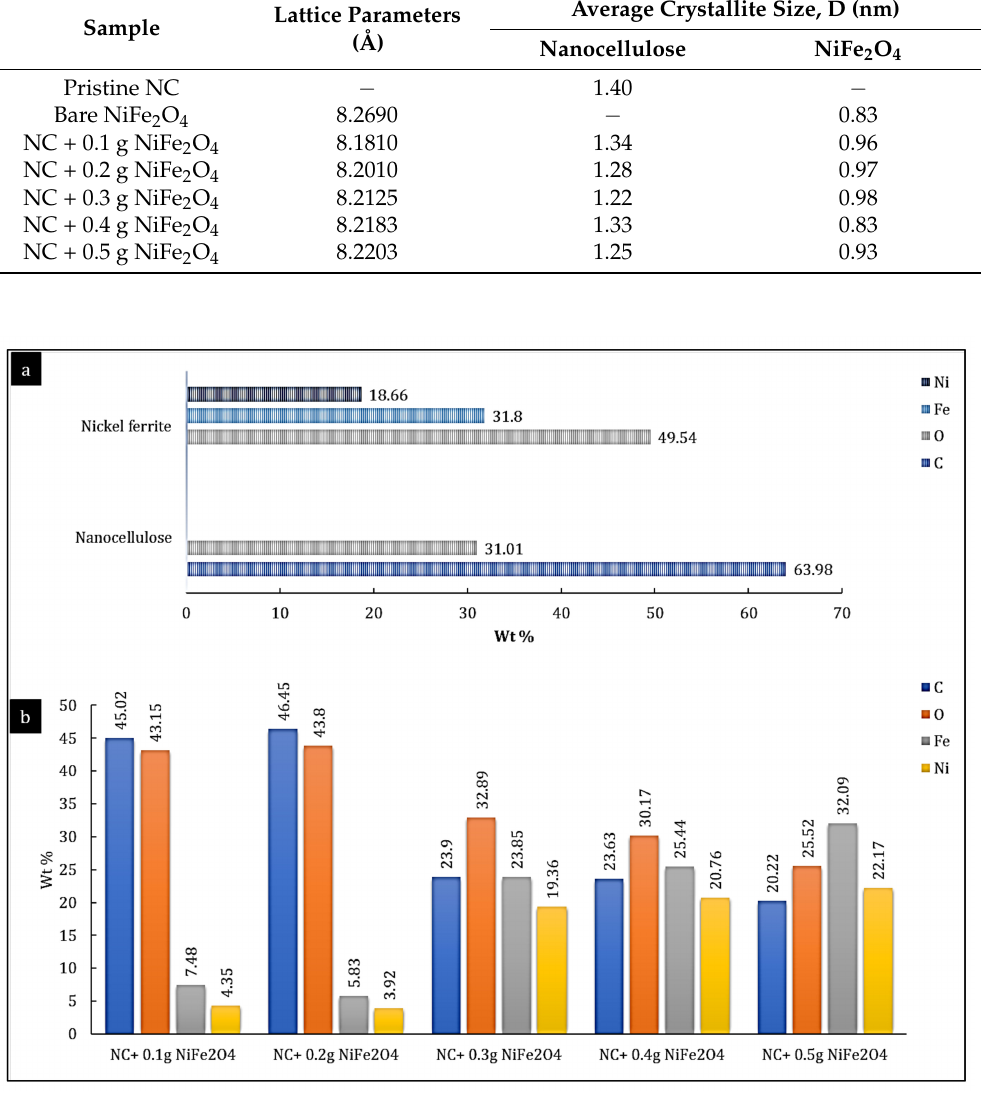
Figure 6. Elemental composition of ( a ) nanocellulose and nickel ferrite ( b ) hybrid